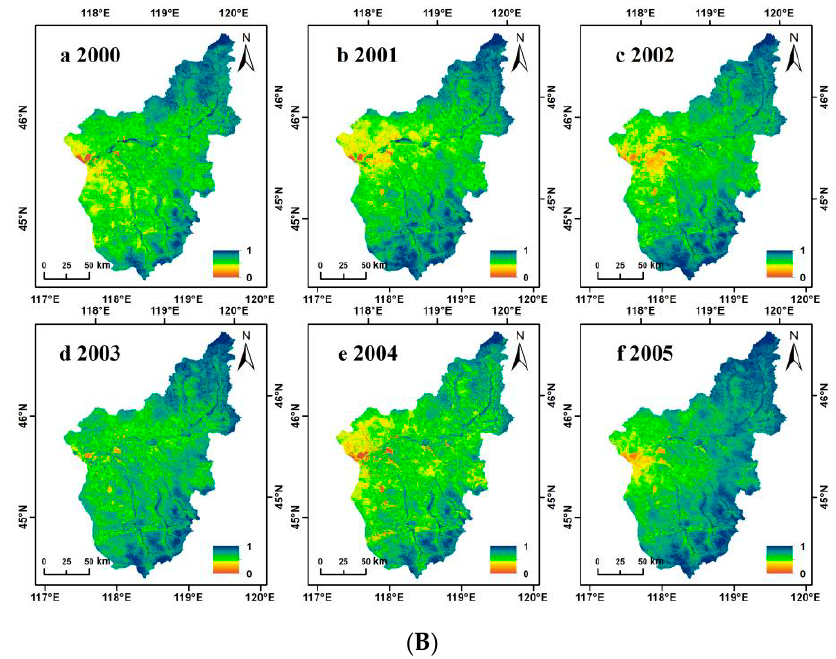
Figure 4. ( A ) Prediction images (enhanced spatial and temporal adaptive reflectance fusion model normalized difference vegetation index; ESTARFM NDVI) from 1997 to 2005. ( B ) Actual images (moderate resolution imaging spectroradiometer normalized difference vegetation index; MODIS NDVI) from 2000 to 2005.